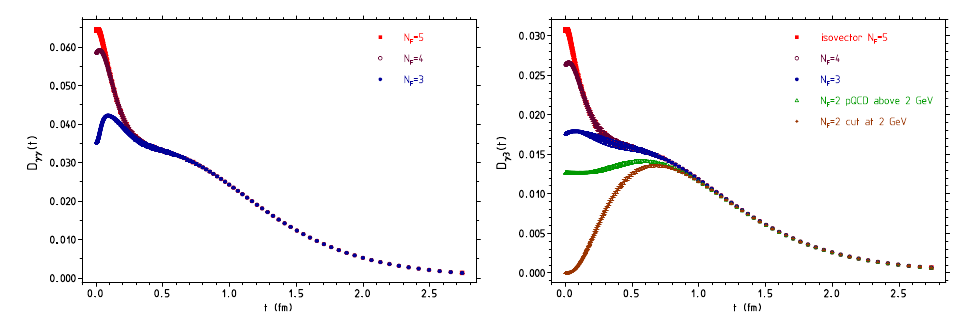
Figure 3. Euclidean correlators. Left: correlator In the ( u , d ) sector